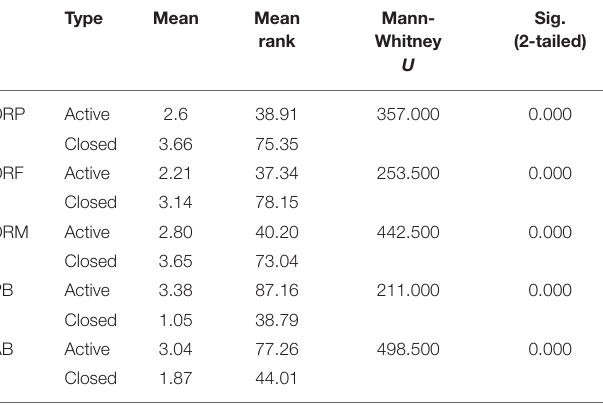
TABLE 7 | Mean and ranking of adaptive and passive behavior in active MSEs. Rank Behaviors Mean